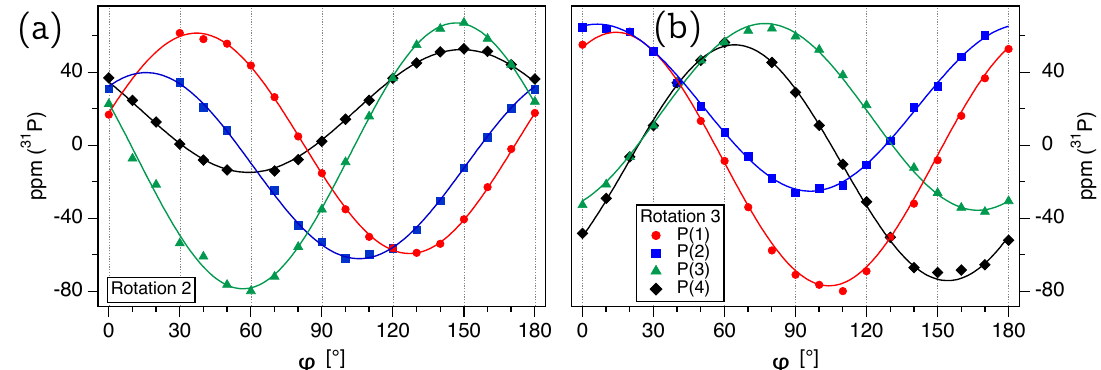
Figure 3. (a) Single crystal of aluminum nitride, AlN, from Leibniz Institute for Crystal Growth (IKZ, Figure 3. Full rotation pattern for the four magnetically inequivalent 31 P in LDP at Wyckoff position Berlin), with the crystallographic c axis and ab plane indicated by arrows.[10] (b) Wurtzite structure 4 a , acquired by rotating the crystal counter-clockwise in steps of 10 o around the goniometer axes (cid:126) g 2 ( a ), of AlN, according to Reference[9], viewed down the crystallographic (11-20) direction. The aluminum and (cid:126) g 3 ( b ). The lines represent the fit of the experimental points to the CS tensor elements and axes atoms (grey) and the nitrogen atoms (yellow), both located at Wyckoff position 2 b , are tetrahedrally orientation (see text for coordinated by each other with one Al-N bond directed parallel to the crystallographic c axis. (c) Individual, tetrahedrally coordinated, aluminum and nitrogen atom in the crystal structure of AlN, in which the three equal, shorter, bonds Al/N—I/II/III [1.8891(8)Å] and the longer bond Al/N—IV [1.9029(16)Å] along the three-fold rotation axis are highlighted. a Drawing generated with the Vesta program [11].